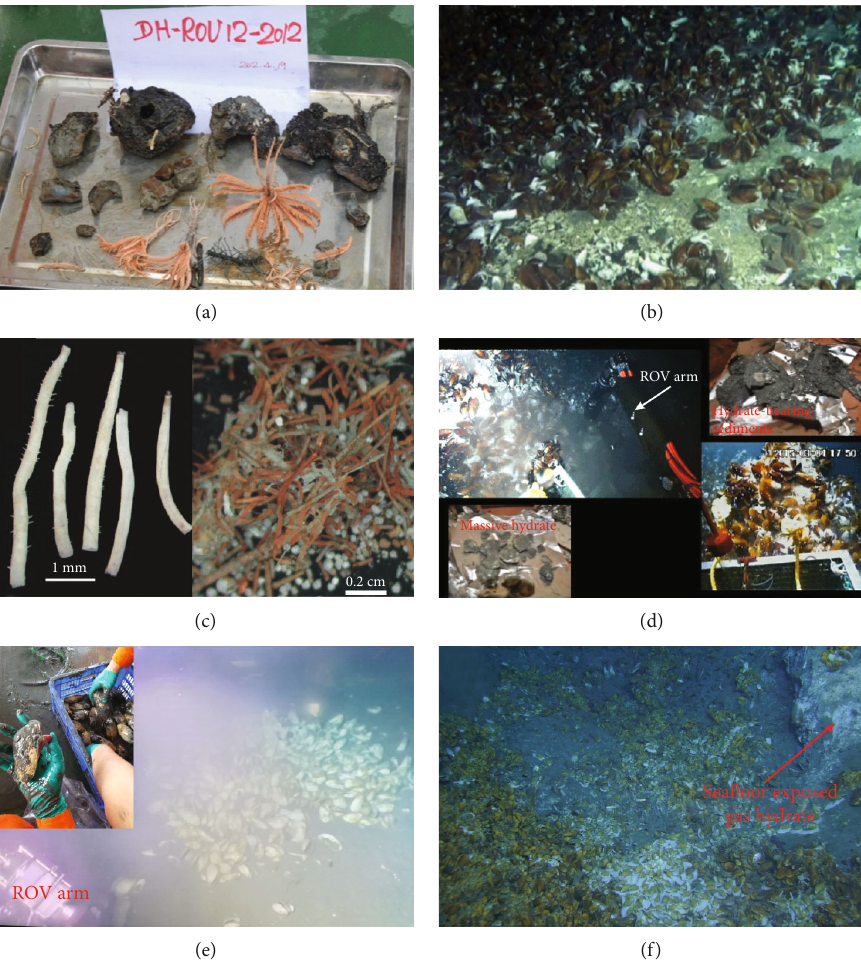
Figure 2: (a) Chimney-like carbonate crusts recovered from the Jiulong Methane Reef. (b) Microbial communities found at the active cold seep in Site F [17]. (c) Tube worms and specimens obtained from the Gaoping slope in the Taixinan Basin [95]. (d) Carbonates, bivalve communities, and massive gas hydrates recovered from the Haima Cold Seep. (e) Bivalve communities discovered by the Haima ROV in a new cold seep developed in the GMGS5 gas hydrate drilling zone, northeastern the Haima Cold Seep. (f) Microbial communities, carbonate crust, and gas hydrates exposed on the sea fl oor, discovered in a new cold seep near the Haima Cold